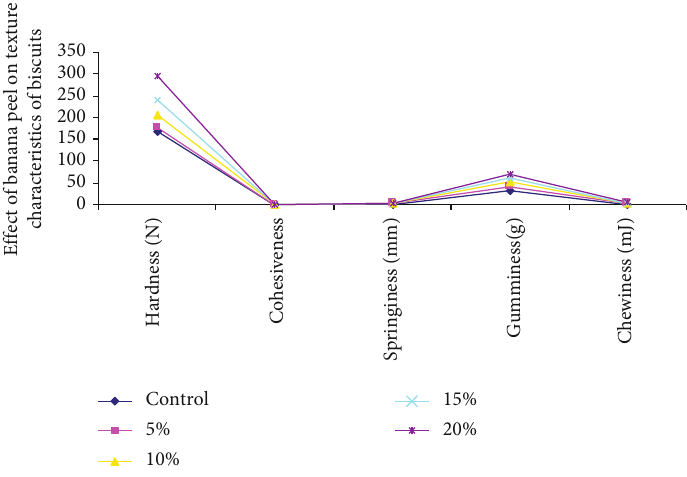
Figure 3: Texture characteristics of di ff erent blends of biscuits. Table 7: E ff ect of banana peel on physical characteristics of